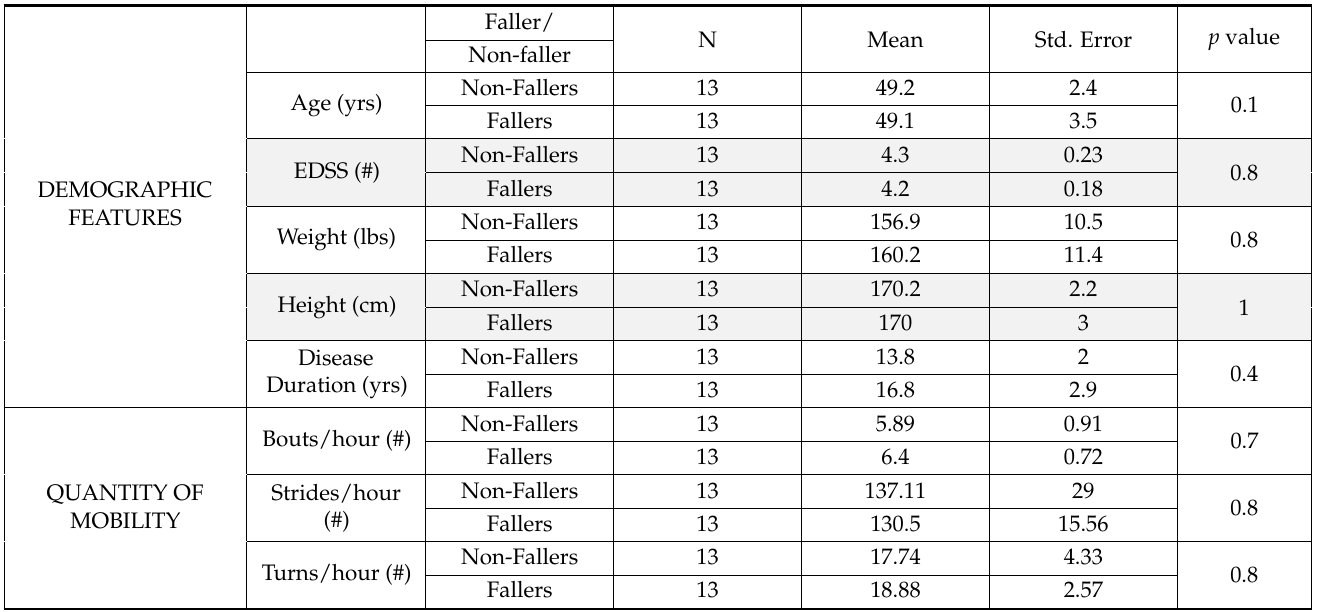
Table 1. Demographic features of the study population along with the quantity of mobility in daily life. Fallers were defined as people with MS who experienced more than 1 fall in the following year after their recruitment in the study.